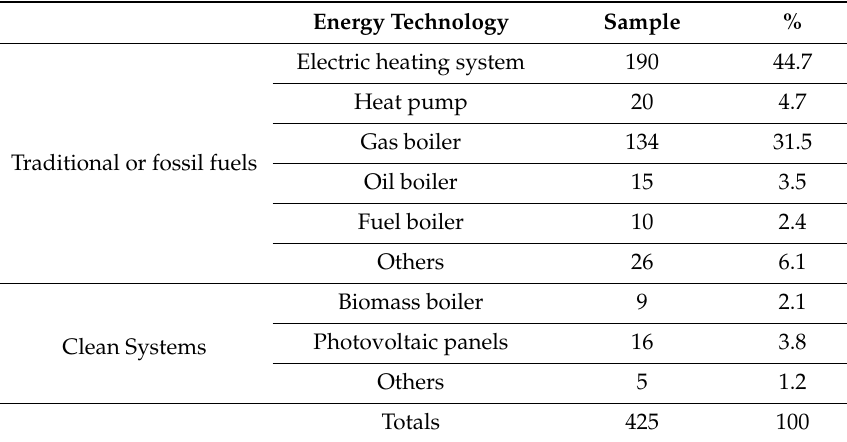
Table 2. Respondents’ current heating